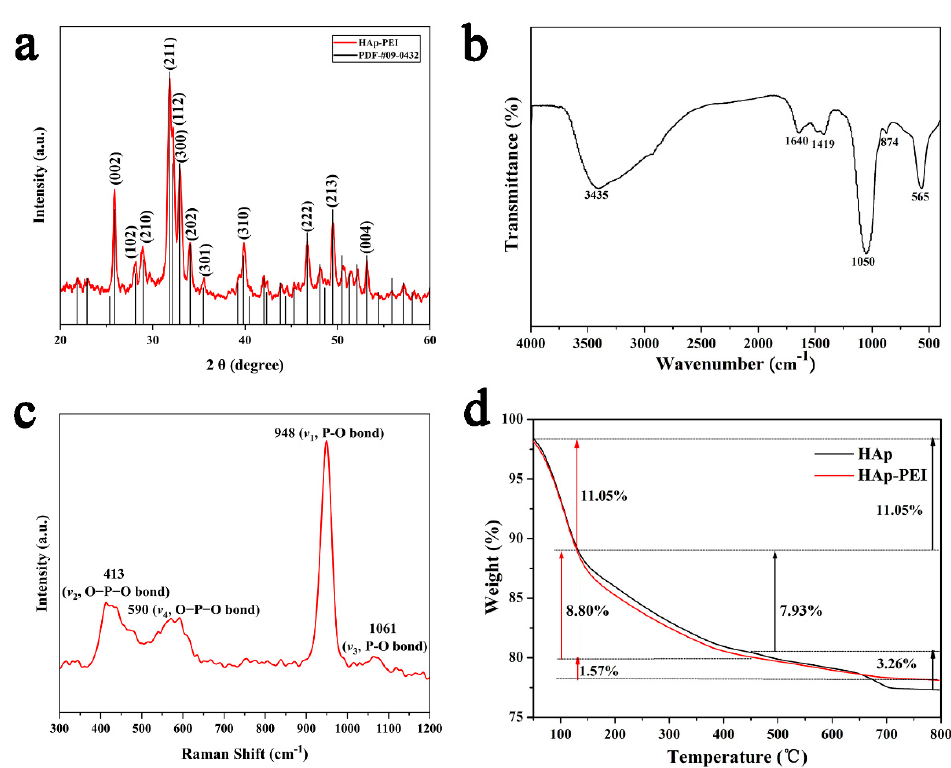
Figure 2. ( a ) XRD pattern, ( b ) FTIR and ( c ) Raman spectra of HAp-PEI, and ( d ) TG curves of HAp and HAp-PEI.